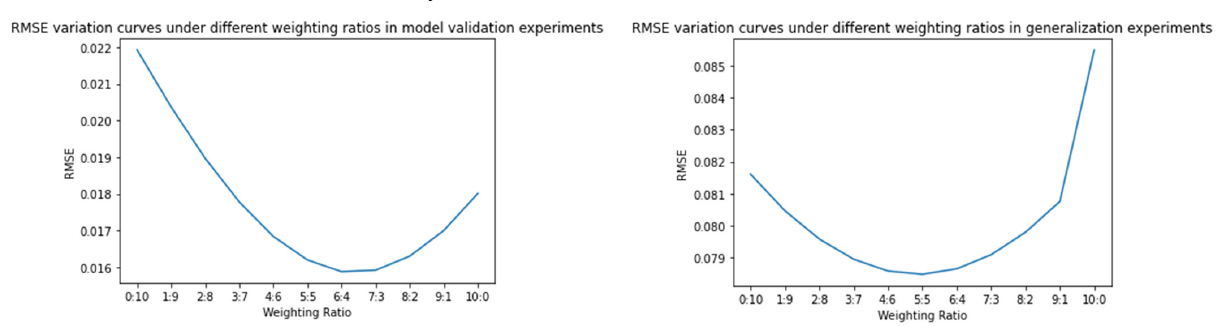
Figure 10. RMSE change curves under different weight ratios in model validation experiment and generalization experiment.